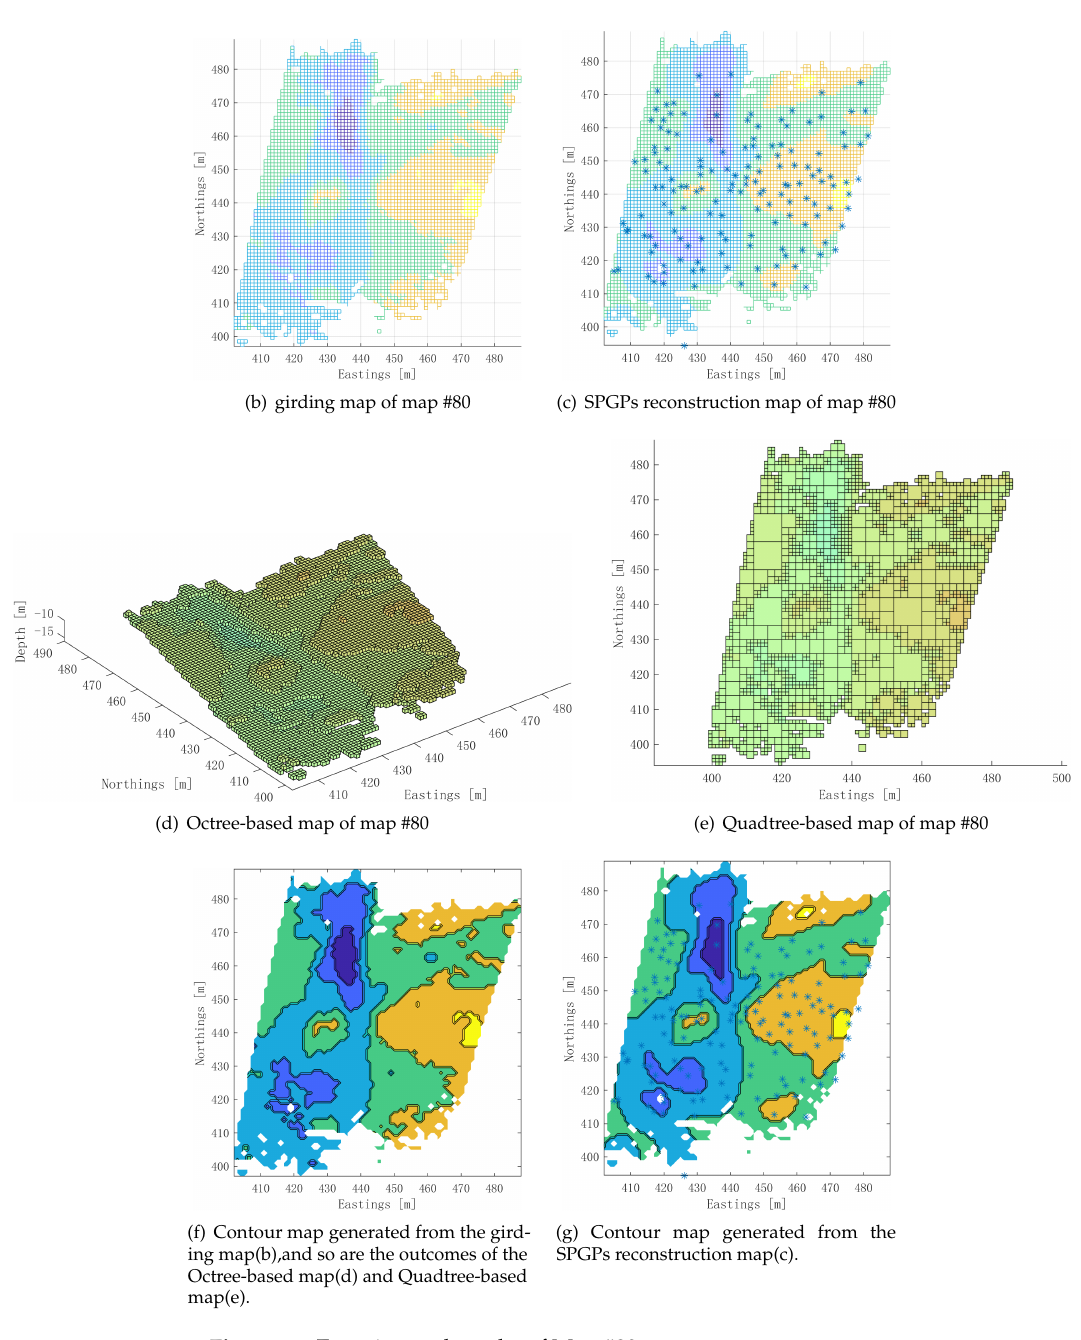
Figure 13. Experimental results of Map #80.